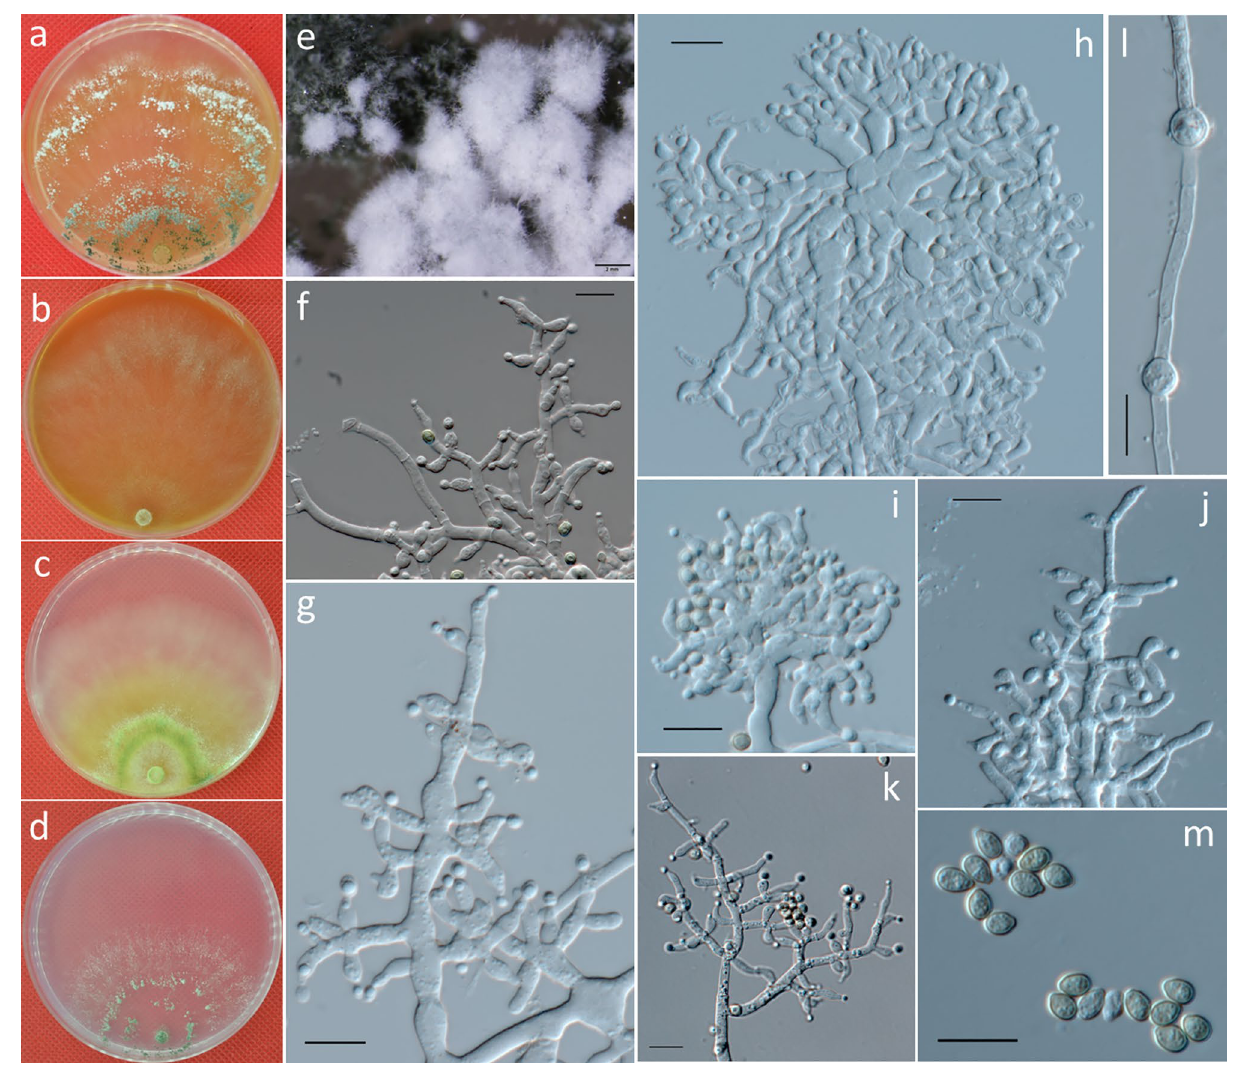
Figure 4. Cultures and asexual morph of Trichoderma zoigense. ( a–d ). Cultures at 20 °C [( a ) on CMD, 7 days; ( b ) on MEA, 4 days; ( c ) on PDA, 4 days; and ( d ) on SNA, 7 days]. ( e ) Conidiation tuft (CMD, 4 days). ( f–k ) Conidiophores and phialides (CMD, 5–7 days). ( l ) Chlamydospores (PDA, 8 days). ( m ) Conidia (CMD, 5 days). Scale bars: ( e ) = 2 mm; ( f–m ) = 10